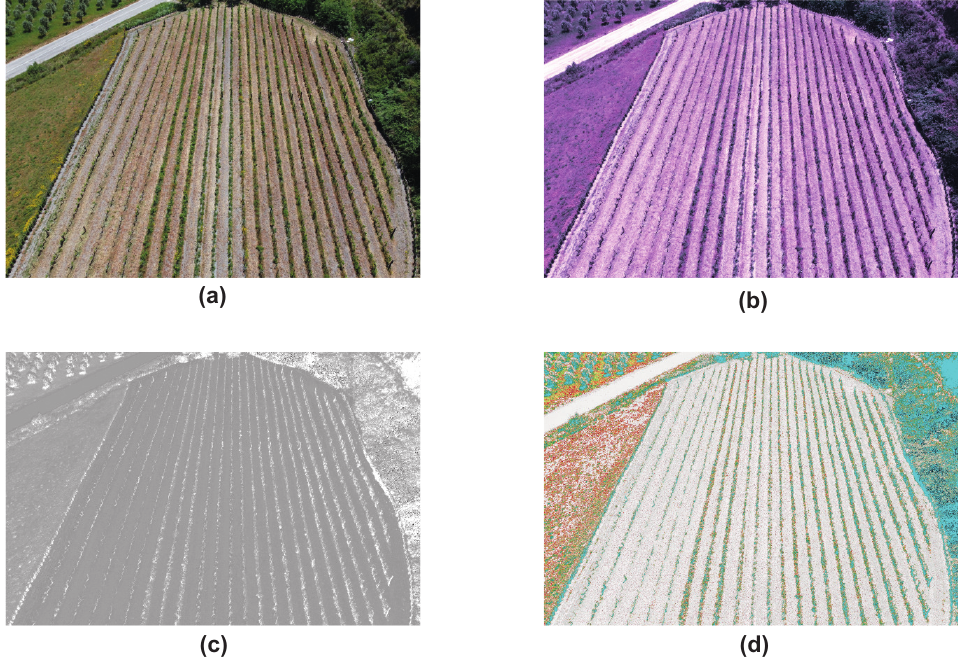
Figure 20. Site 1— NDVI analysis: original image ( a ), multi-spectral image ( b ), gray-scale image ( c ) and NDVI image ( d ).